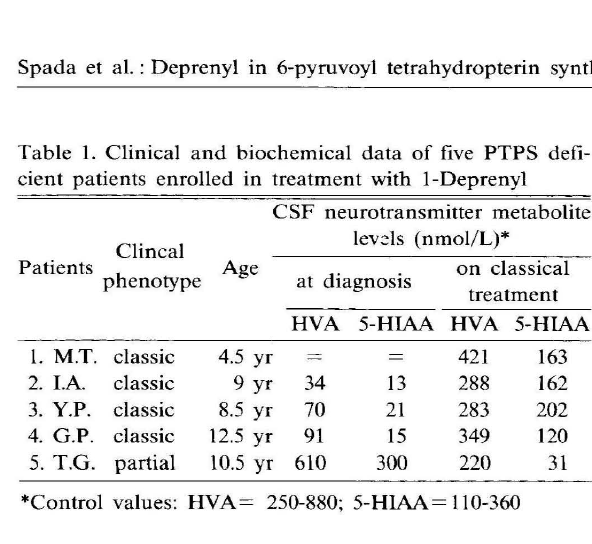
Treatment before and after Cinical picture